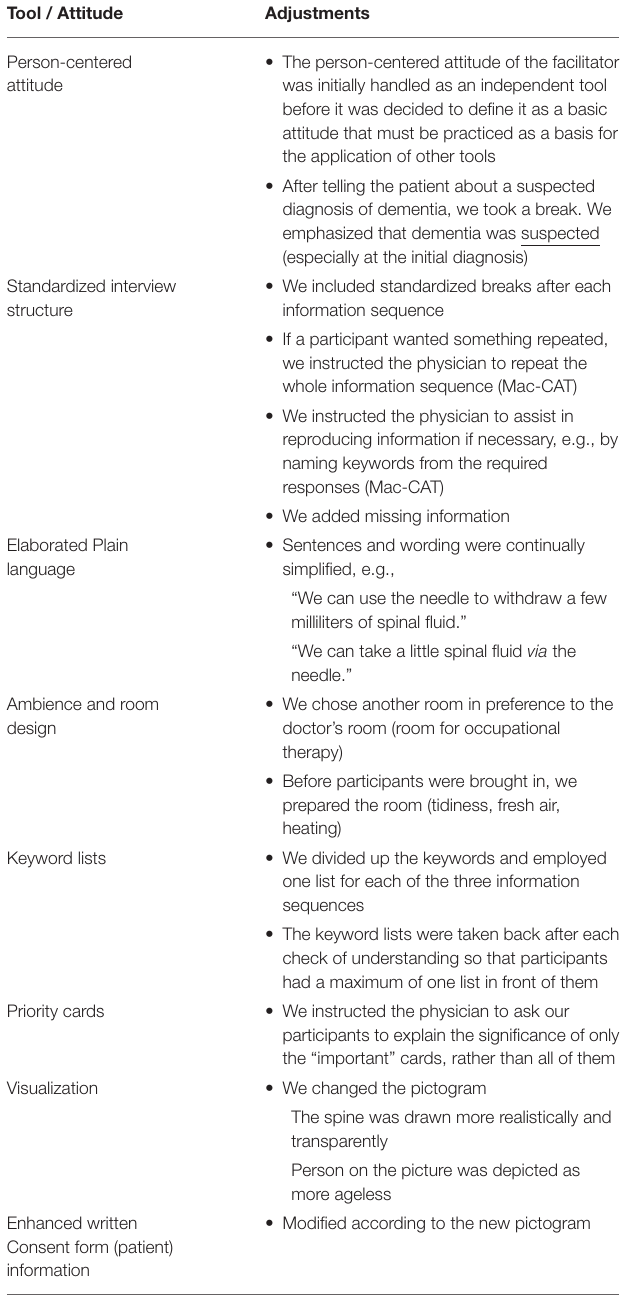
TABLE 1 | Adjustments to applied support